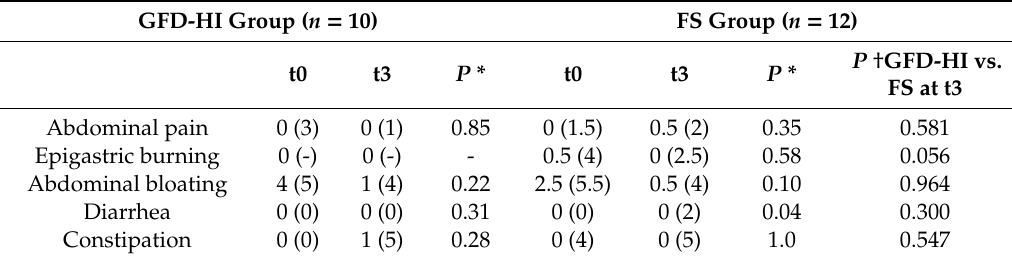
Table 2. Gastrointestinal symptoms reported by the patients during the